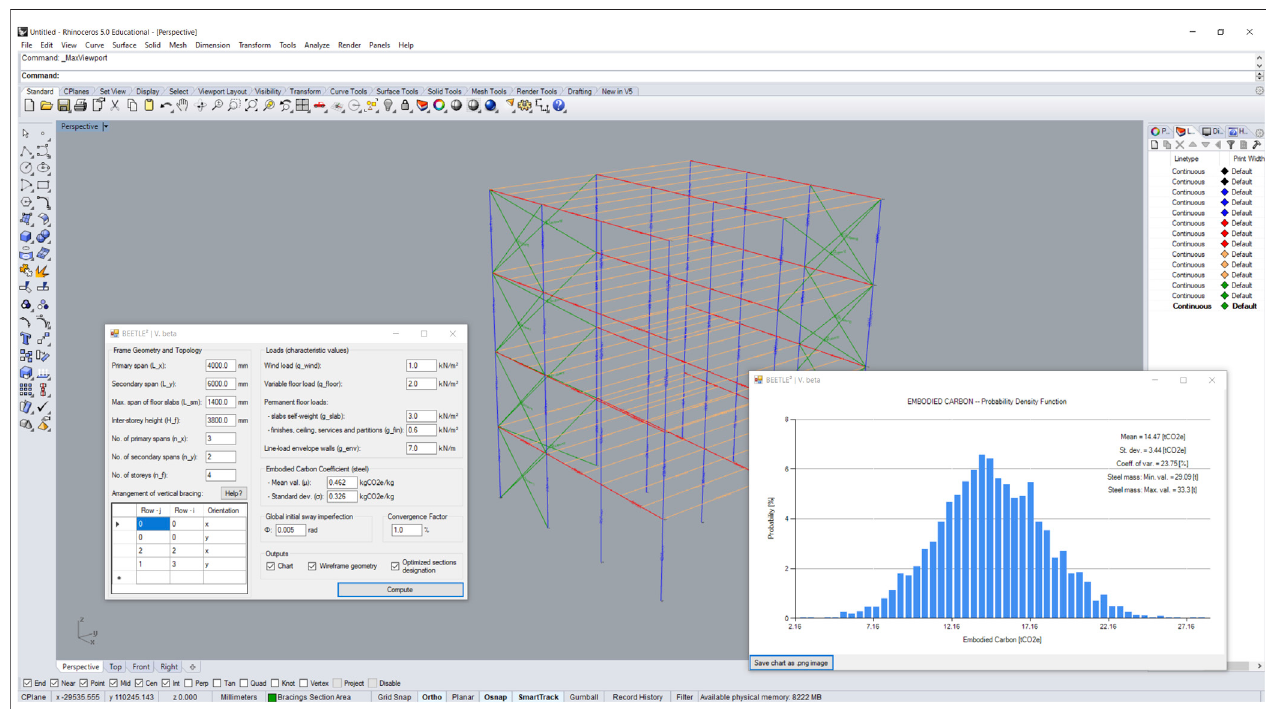
FIGURE 5 | Graphical User interface of the FEM-based tool, implemented as a plugin for Rhinoceros 3D.